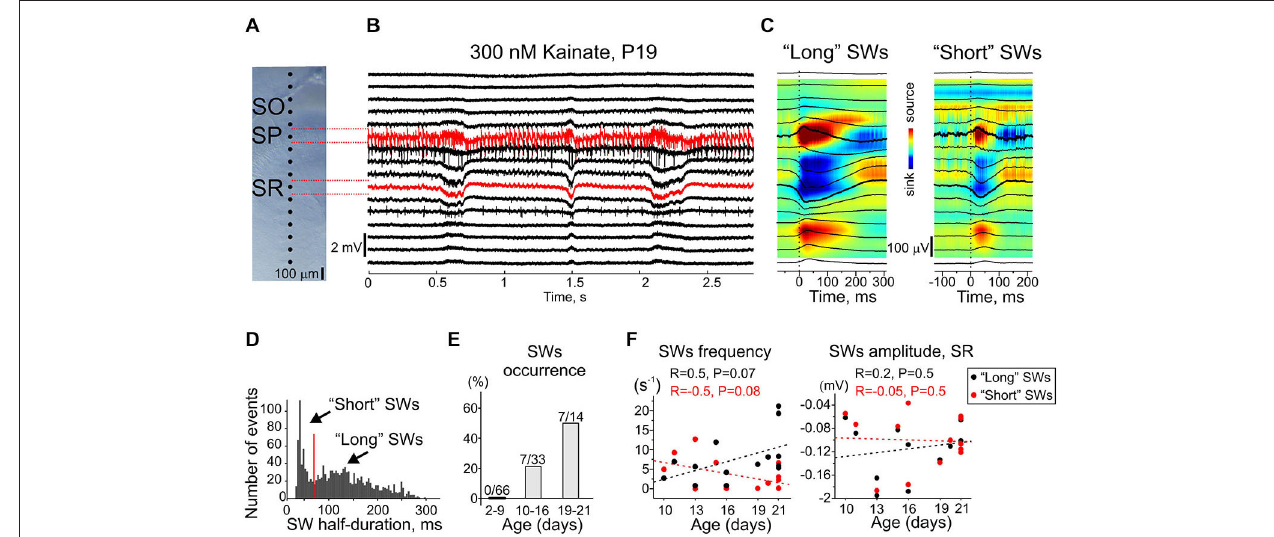
traces) overlaid on CSD. Time = 0 corresponds to the SWs’ front. (D) Half-duration histogram of SWs. (E) SWs’ occurrence for three age groups (66 P2–9 slices, 33 P10–16 slices and 14 P19–21 slices). (F) Frequency (left) and amplitude in stratum radiatum (right) of short (red dots) and long (black dots) SWs. Dashed lines show linear regression of pooled data (47 slices P10–21 with SWs). R, linear regression coefficient and P -values are shown at the